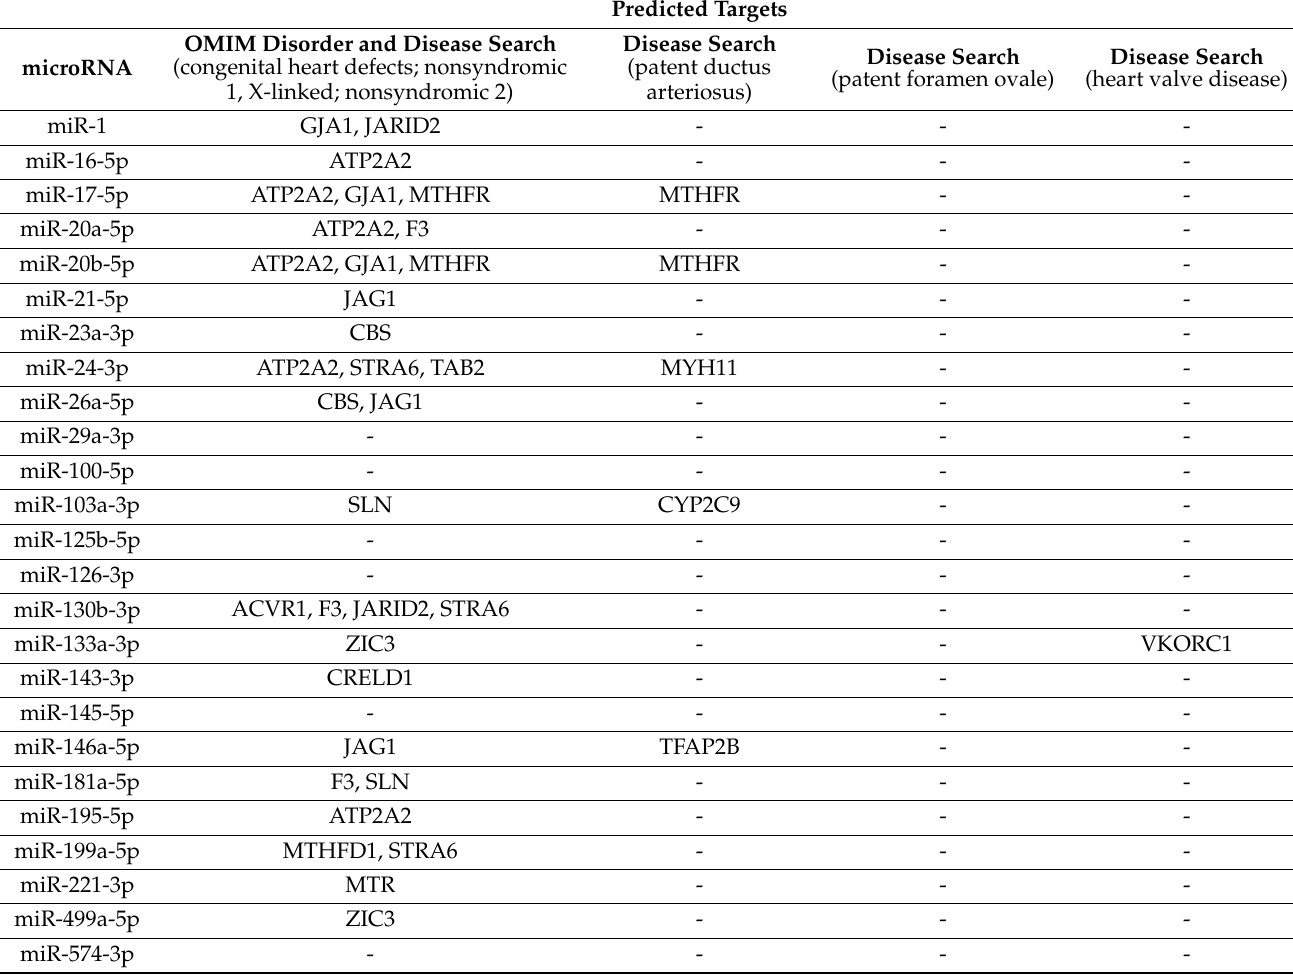
Table 8. A list of predicted targets of microRNAs dysregulated in the whole peripheral blood of preterm-born children in relation to congenital heart defects and heart valve disease, using the miRWalk2.0 database (data available in the Disease Search database and the OMIM Disorder